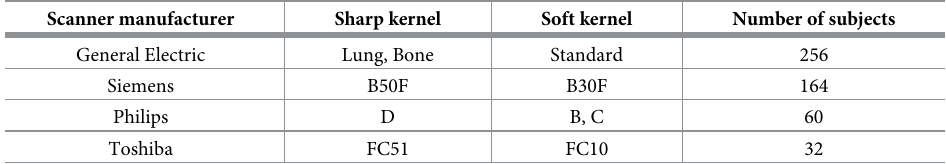
Table 2. Scanner manufacturers and used reconstruction